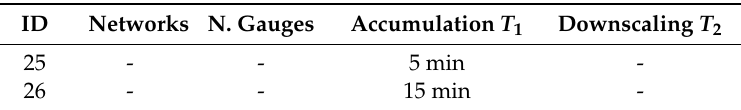
Table 5. Non-corrected radar products are compared as well, at two different resolutions in the Dutch case